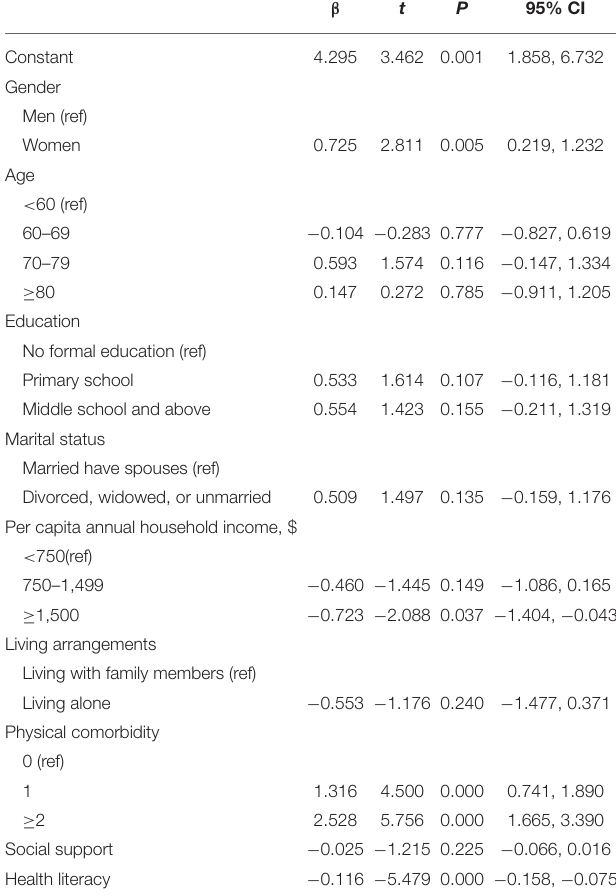
FIGURE 2 | Structural analysis of social support, physical comorbidity, health, literacy, and depression. All coefficients are significant ( P <